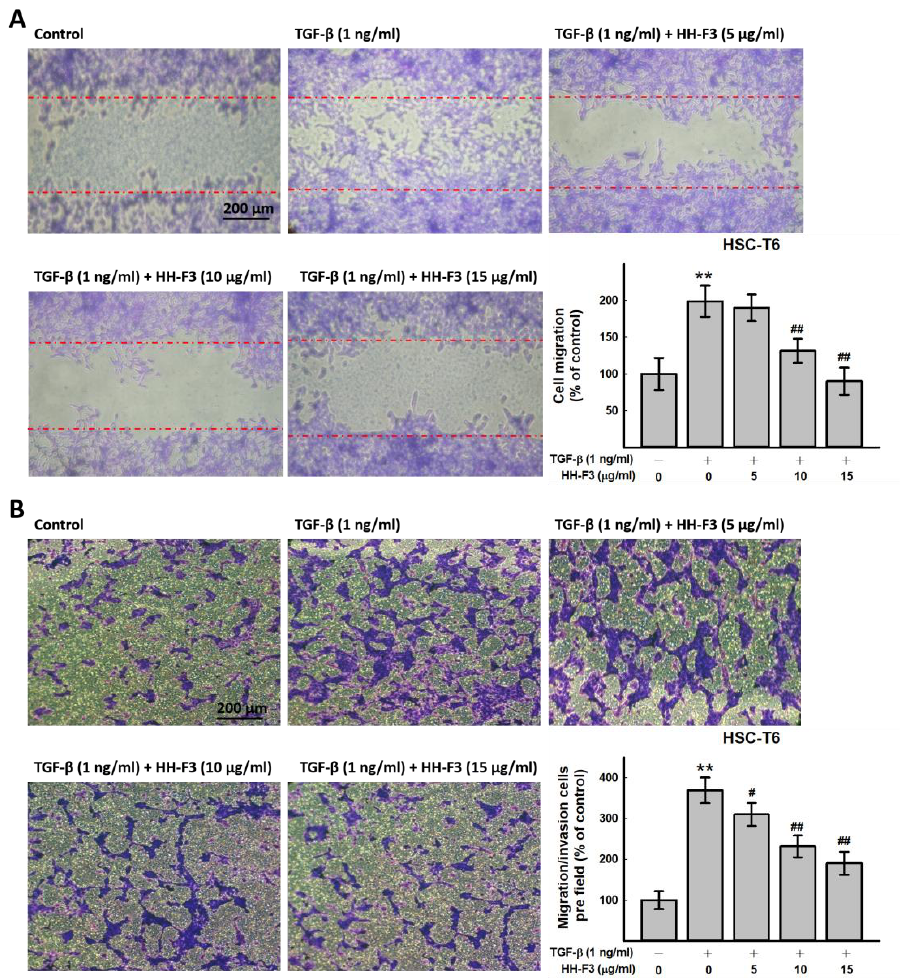
Figure 4. HH-F3 affects the migration ability of TGF-β-activated HSC-T6 cells. Cell migration was monitored by using wound-healing and transwell invasion assays. ( A ) For wound-healing assays, cells were seeded into culture inserts. HSC-T6 cells were pretreated with 1 ng/mL TGF-β1 and then treated with 5 μg/mL, 10 μg/mL, or 15 μg HH-F3 for 24 h. Red dotted lines are started wound edges. ( B ) For migration/invasion assays, cells were seeded into the top of a transwell insert. HSC-T6 cells were cotreated with 1 ng/mL of TGF-β1 and 5 μg/mL, 25 μg and 50 μg/mL HH-F3 for 24 h. After eight hours, the cells on the top were scraped, and the cells that had migrated to the bottom were fixed and stained with Giemsa. The relative-fold migration values were normalized against the negative control and are represented diagrammatically. ** p < 0.01 compared to the control group; # p < 0.05, ## p < 0.01 compared to the TGF-β1-induced group.